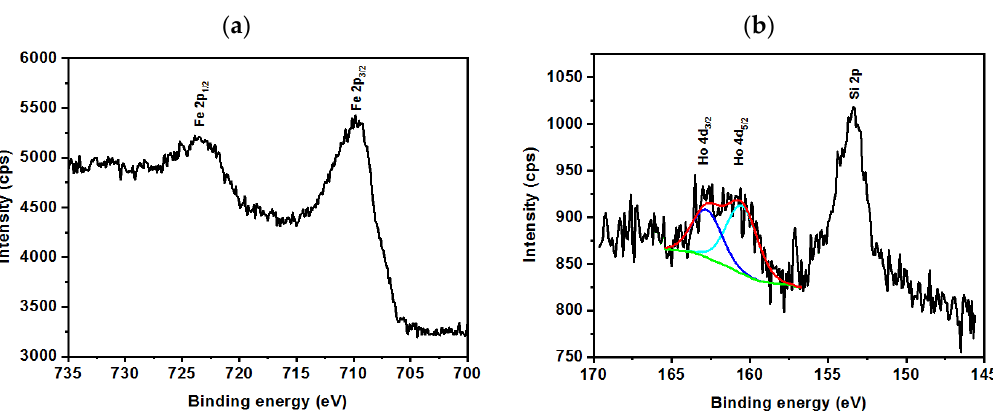
Figure 3. XPS spectrum for shows the region for ( a ) Fe 2p binding energies and ( b ) Ho 4d binding energies.